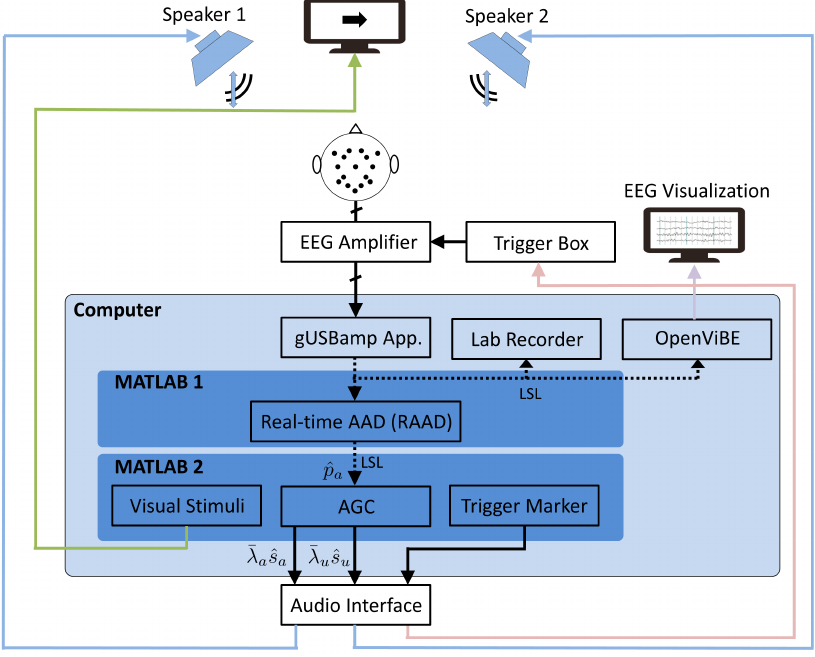
Figure 2. Overview of the proposed cognitive-driven gain controller system for a scenario with two competing speakers. The EEG responses were acquired using the EEG amplifier. The acquired EEG responses and EEG trigger markers were streamed using the gUSBamp application. Using the gUSBamp application and the LSL software package, the streamed EEG responses were forwarded to the real-time AAD (RAAD) for online decoding, to the Lab Recorder application for recording, and to the OpenViBE software for online EEG visualization. The RAAD was implemented and run using MATLAB (MATLAB 1). The RAAD identified the attended and the unattended speaker and generated their corresponding probabilistic attention measure. The generated probabilistic attention measure of the attended speaker ( ˆ p a ) was forwarded to the AGC using the LSL software package. Based on the probabilistic attention measure, the AGC amplified the attended speaker (¯ λ a ˆ s a ) and attenuated the unattended speaker (¯ λ u ˆ s u ) as acoustic stimuli. The AGC (together with trigger marker and visual stimuli) was implemented and run using MATLAB (MATLAB 2). The AAD loop was then closed by presenting the acoustic stimuli using the audio interface and two